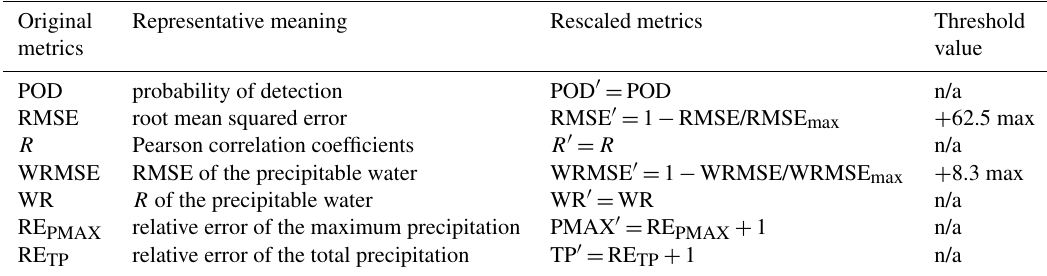
Table 2. Correlations between the original and rescaled objective verification metrics. Original Representative meaning Rescaled metrics Threshold